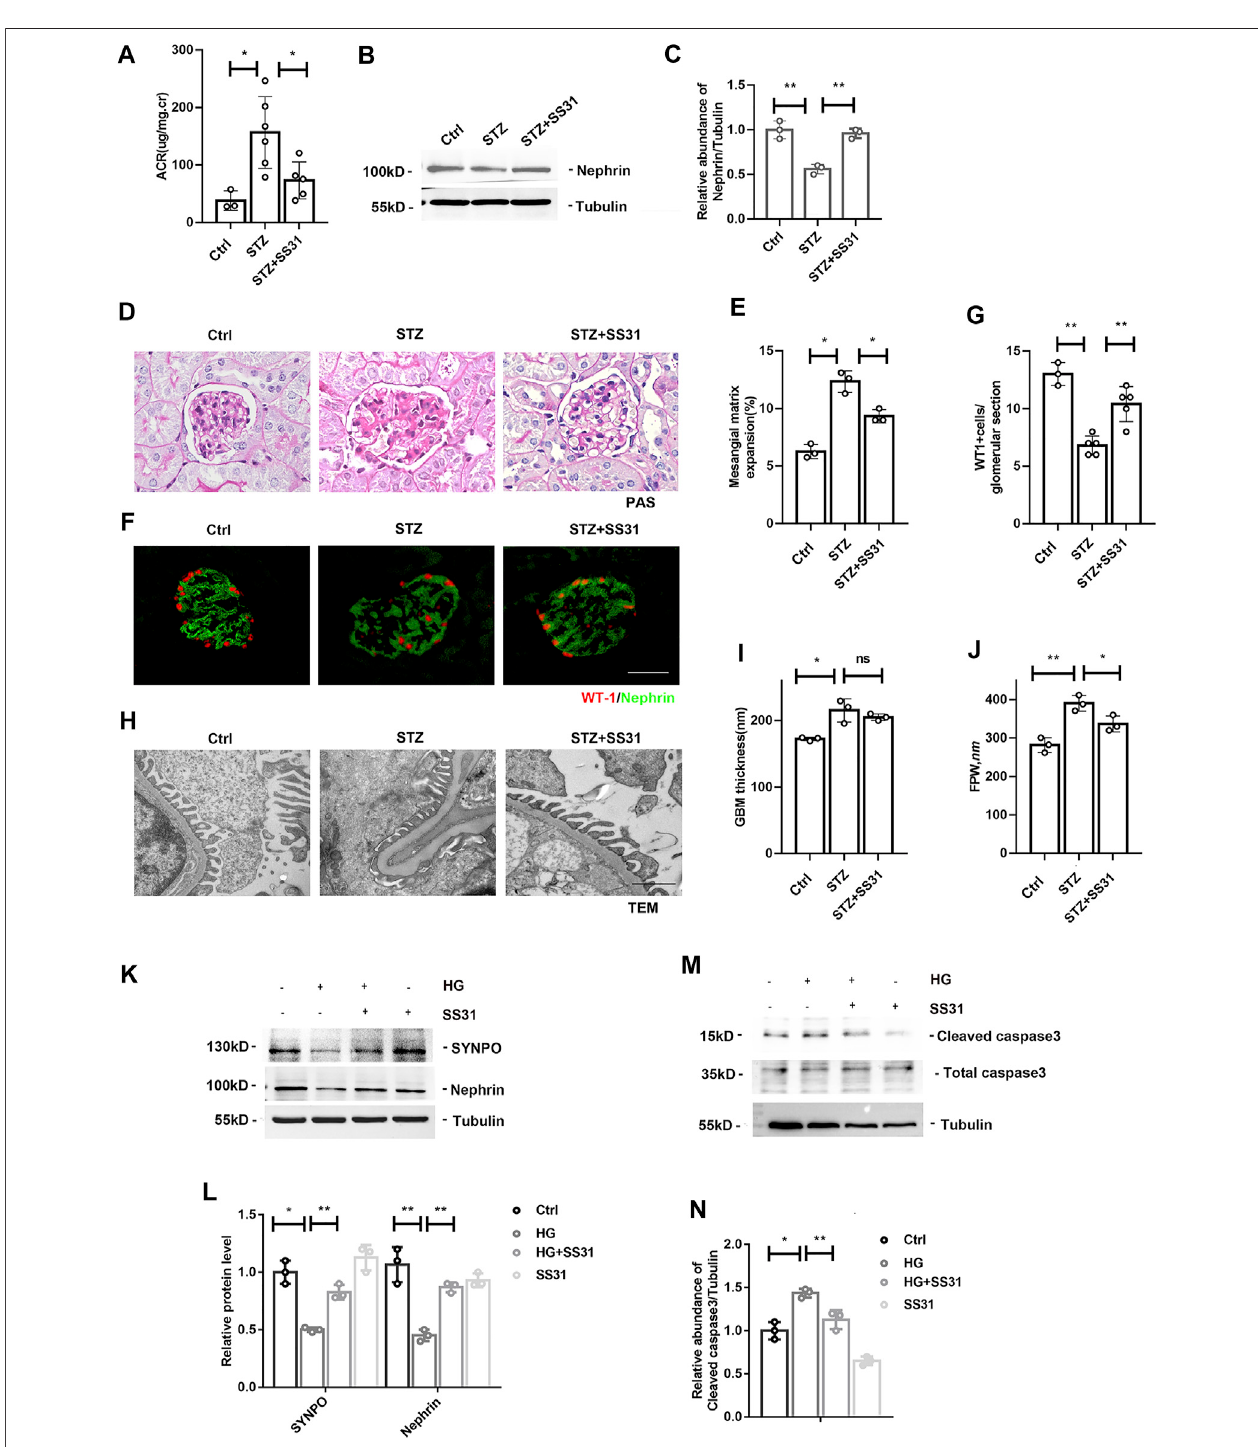
FIGURE 2 | SS31 inhibits HG-induced podocyte injury. (A) Urinary albumin-creatine ratio of indicated groups. n (cid:1) 3 – 6, * p < 0.05: p (cid:1) 0.01(Ctrl vs STZ); p (cid:1) 0.02(STZ vs STZ + SS31). (B) Western blot analysis showing protein expression of Nephrin in glomeruli from indicated groups at week 12 after successful induction of diabetes. (C) Semi-quantitativedensitometryanalysisforNephrinexpression.n (cid:1) 3,** p < 0.01: p (cid:1) 0.004(CtrlvsSTZ); p (cid:1) 0.002(STZvsSTZ+SS31). (D) Renalhistology ofglomerulibyPASstaininginindicatedgroups.(Bar (cid:1) 25 μ m). (E) Thehistogram representing statistical analysisofsclerosed glomeruliinindicatedgroups.n (cid:1) 3, * p < 0.05: p (cid:1) 0.014(Ctrl vs STZ); p (cid:1) 0.018(STZ vs STZ + SS31). (F) Representative immuno fl uorescent images showing WT1 and Nephrin in indicated groups. (Bar (cid:1) 25 μ m) (G) The histogram representing quanti fi cation of WT1. n (cid:1) 3 – 5, ** p < 0.01: p (cid:1) 0.007; p (cid:1) 0.002(STZ vs STZ + SS31). (H) Electron microscopic pictures of